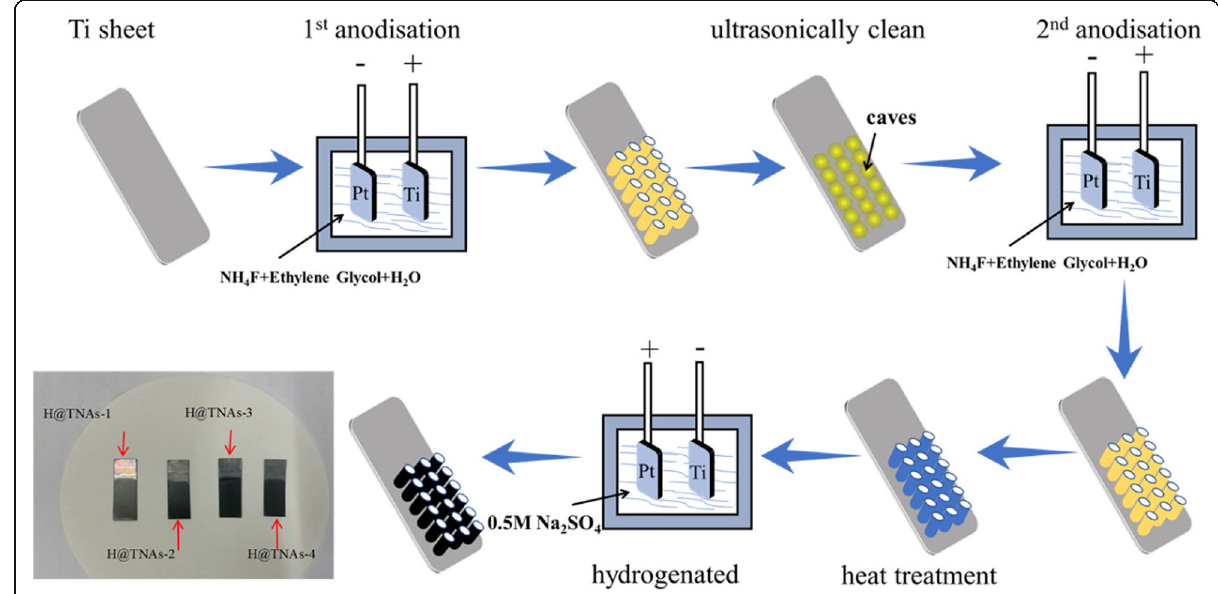
Fig. 1 Schematic diagram of preparation and the optical image of as-prepared